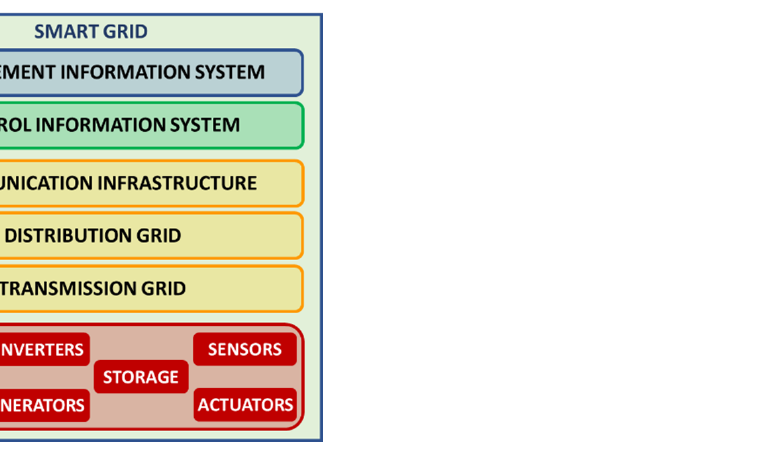
Figure 1. Global perspective of the SG as an SoS, with the physical and cyber infrastructures.